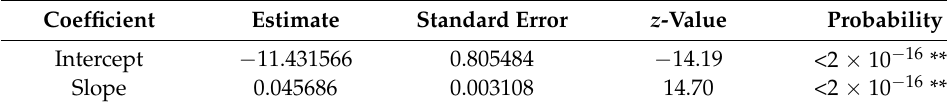
Table 5. Logistic regression coefficients (returned by the glm function in R).